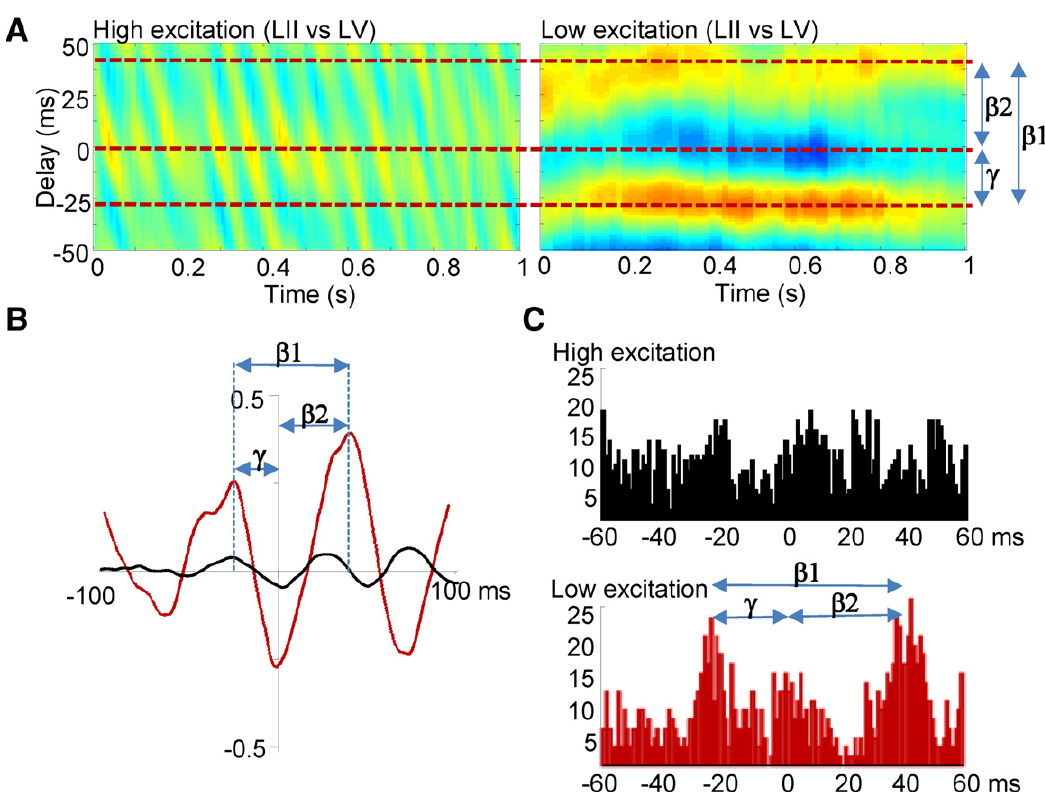
Figure 2. Asymmetric local fi eld potential and spike cross correlations suggest period concatenation across laminae. (A) Cross correlograms from LFP data. During coexpressed gamma and beta2 rhythms (high excitation condition) the phase relationship between LII and LV varied rhythmically at beta1 frequency. When beta1 rhythms were expressed in the local fi eld potential from LII and LV, a phase relationship was seen with LV leading and lagging LII by one gamma and one beta2 period, respectively. (B) Mean cross correlation function between LII and LV (60 epochs of data, n = 5 slices) for coexpressed gamma and beta2 fi eld potentials (black) and beta1 rhythms (red) illustrating the generation of a stable, asymmetric temporal relationship between laminae on reduc- tion in glutamatergic drive. (C) Graphs show distribution of LV units with respect to adjacent LII units during coexpressed gamma/beta2 (black) and beta1 (red) fi eld potential